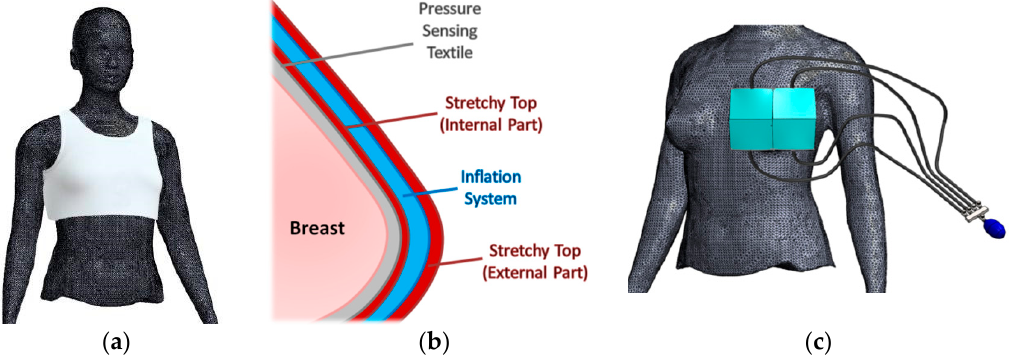
Figure 3. Palpreast conceptual design—( a ) external top; ( b ) internal layer view; and ( c ) inflation system.